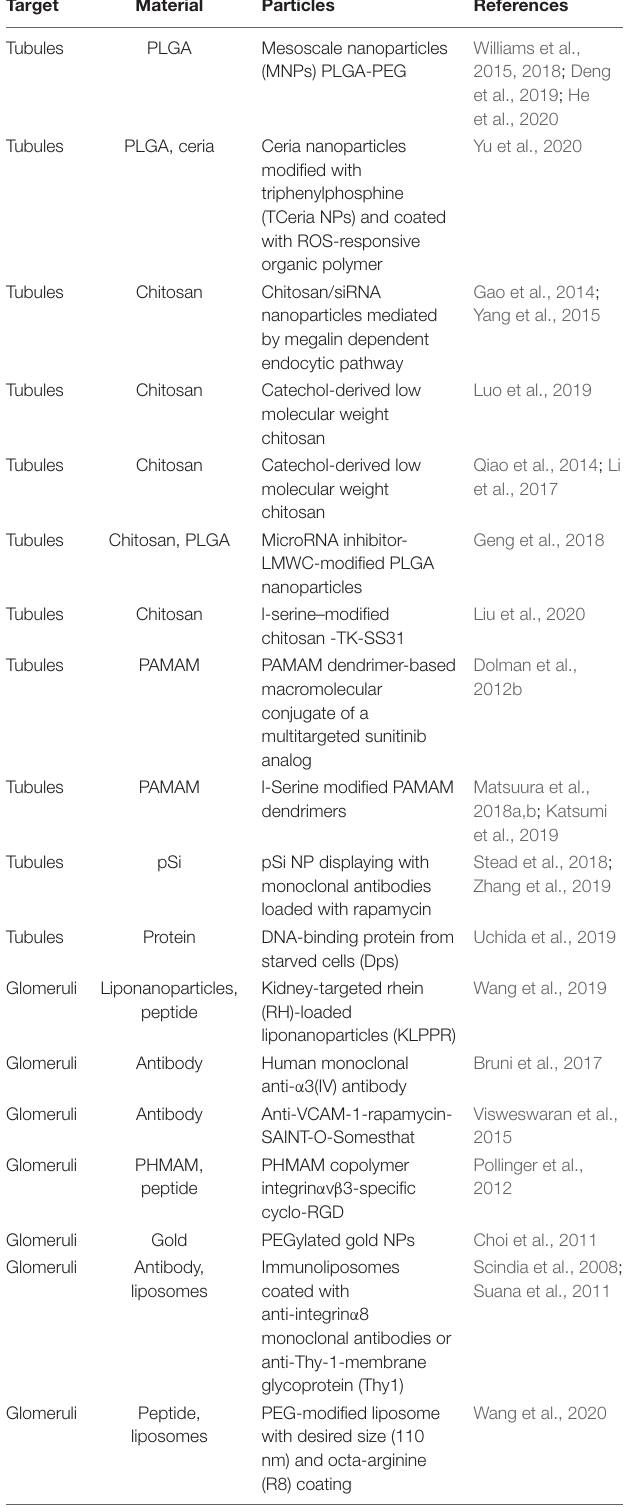
TABLE 1 | Nanomaterials for kidney targeted drug